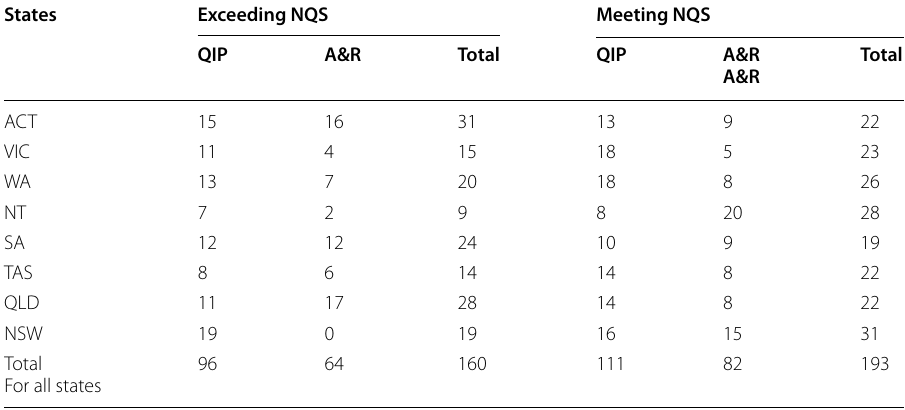
Table 3 Number of references to technology by ECEC setting in each of the eight States/Territory ( N =